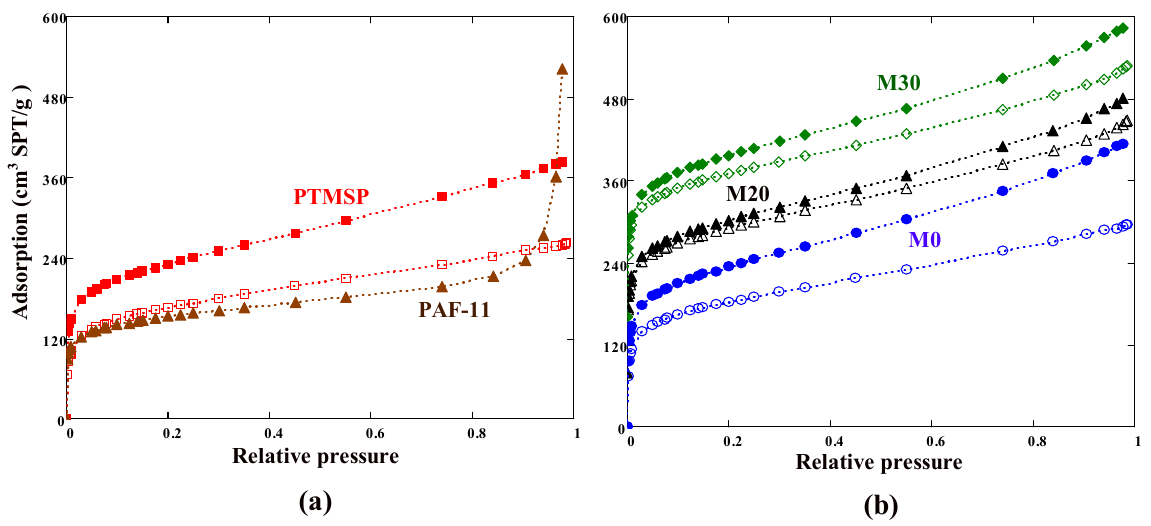
Figure 6. ( a ) Adsorption isotherms of nitrogen on PAF-11 and PTMSP samples and ( b ) adsorption isotherms of nitrogen on M0 (PTMSP/PEI), M20 (PTMSP/PEI/20% PAF-11), and M30 (PTMSP/PEI/30% PAF-11) samples. The isotherms for M20 and M30 were shifted by 80 and 160 cm 3 STP/g, respectively. Closed and open symbols denote PTMSP-based samples before and after CO 2 exposure, respectively.